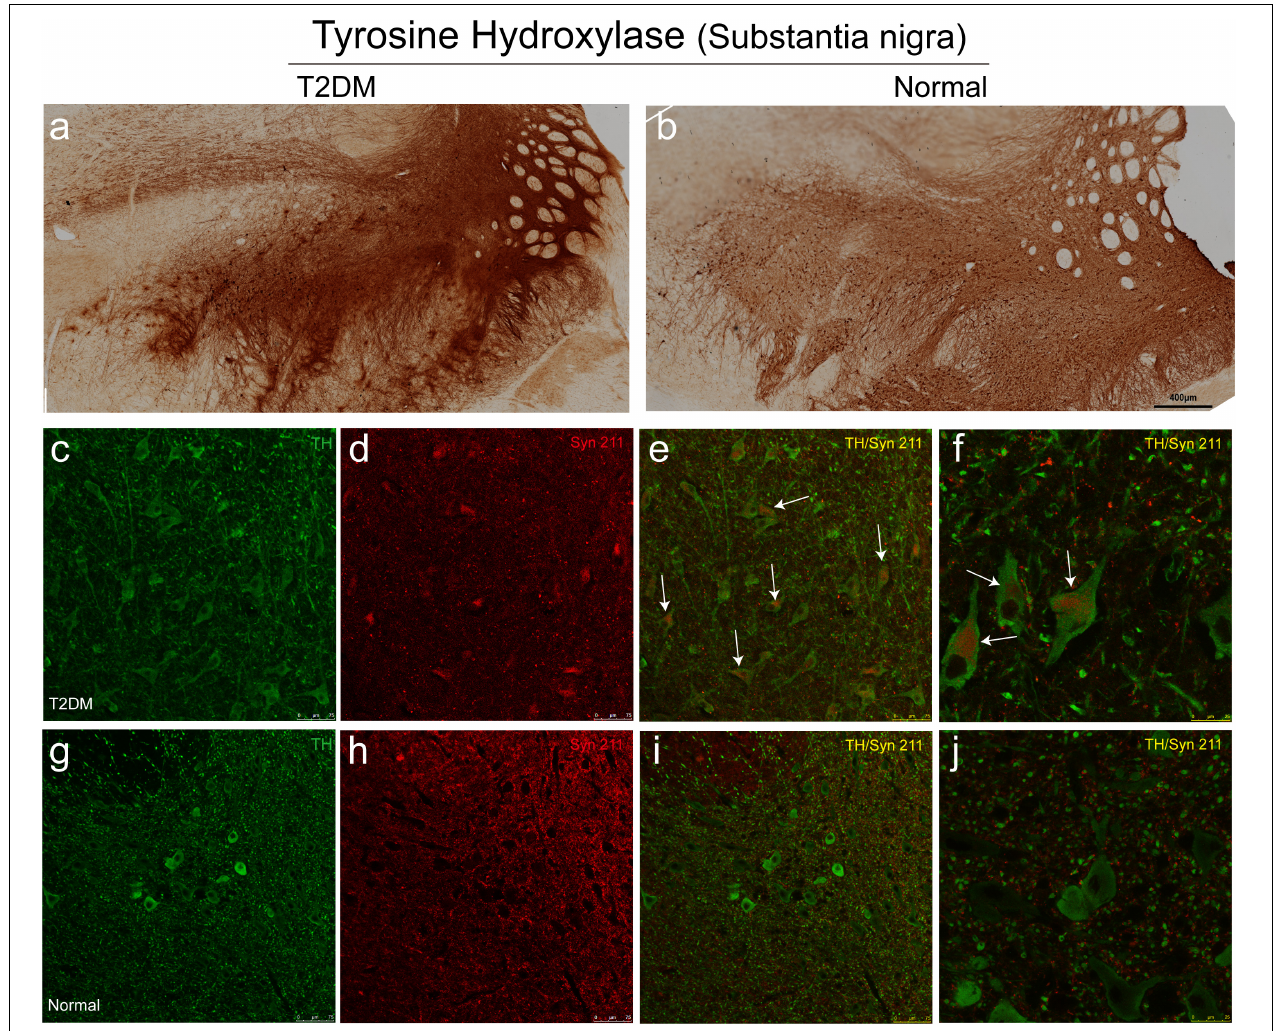
FIGURE 9 | Immunohistochemical images showing presence of dopaminergic neurons of the substantia nigra in diabetic and normal monkeys. An antibody against tyrosine hydroxylase (TH) was used to stain the sections of the substantia nigra in diabetic (a) and normal (b) monkeys. Double immunofluorescence labeling with α -synuclein (Syn 211) (red in d–f,h–j ) and TH (green in c,e,f,g,i,j ) showed increased α -synuclein present in many TH-positive neurons in the diabetic monkey (arrows in e,f ), compared to that in the age-matched normal monkey (i,j) . Scale bar = 400 µ m in (a,b) ; scale bar = 75 µ m in (c–e,g-i) ; scale bar = 25 µ m in (f,j) . High power series images were also shown in the Supplementary Videos S1, S2